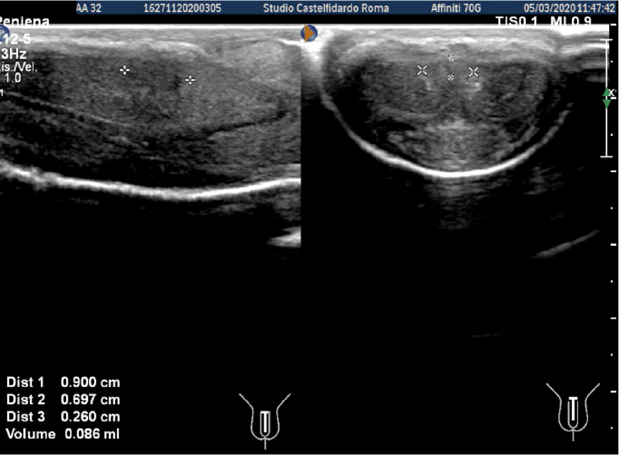
Figure 3. Ultrasonography of the penis after the first treatment cycle (longitudinal and transverse views).